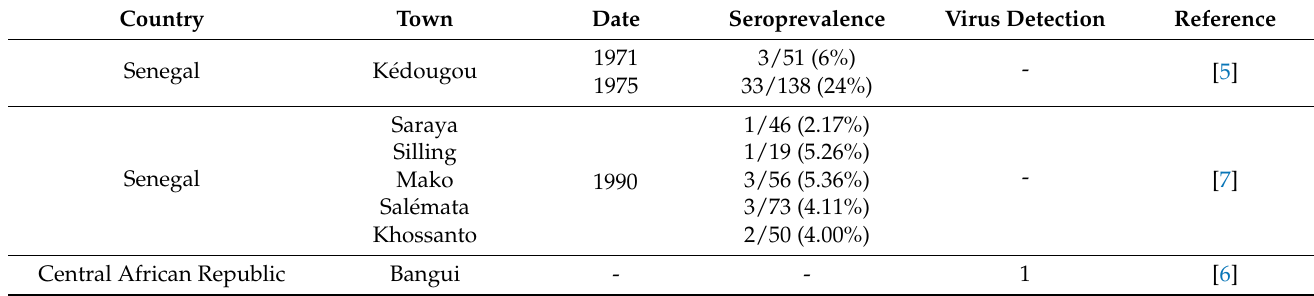
Table 1. Data suggestive of human infection or exposure with KEDV between 1971–1990.